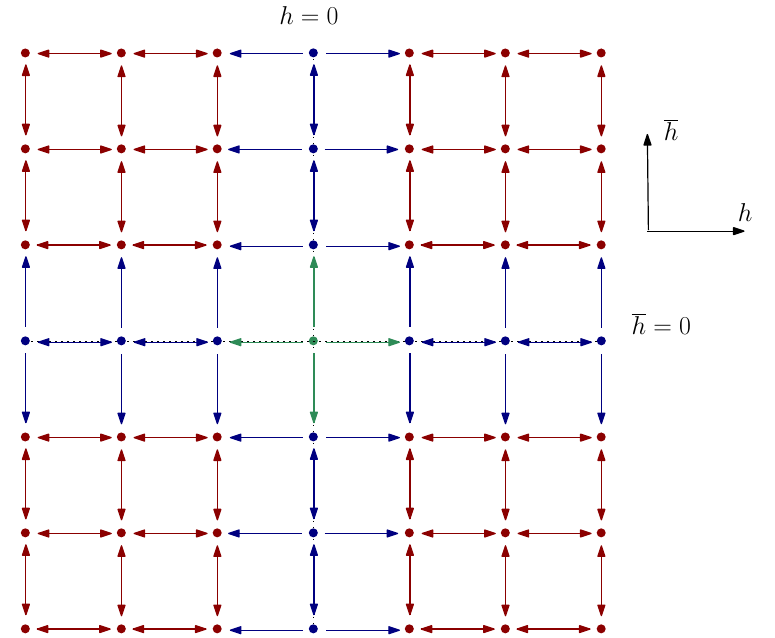
Figure 1 . A diagram showing the SL(2 ; R ) (cid:2) SL(2 ; R ) action on the t + and (cid:22) h . Left/right arrows show non-trivial L (cid:6) actions and down/up arrows indicate non-trivial (cid:22) L (cid:6) actions. The states in dark red form four unitary subrepresentations built on (anti-) primary